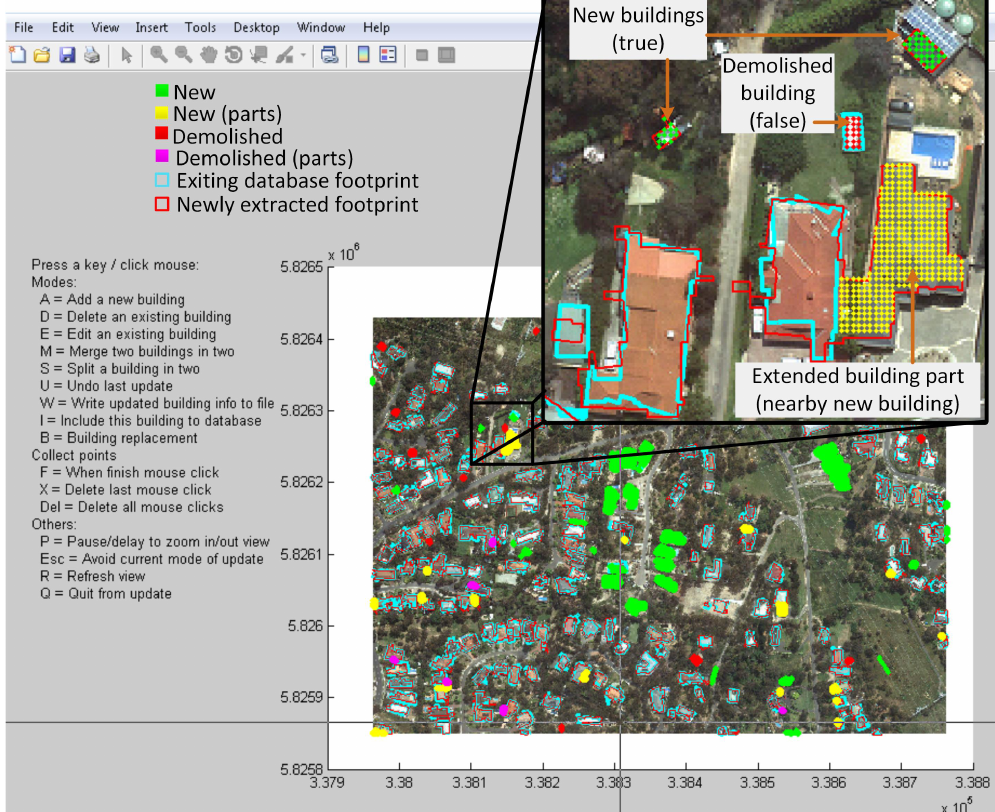
Figure 5. The GUI to update the building map